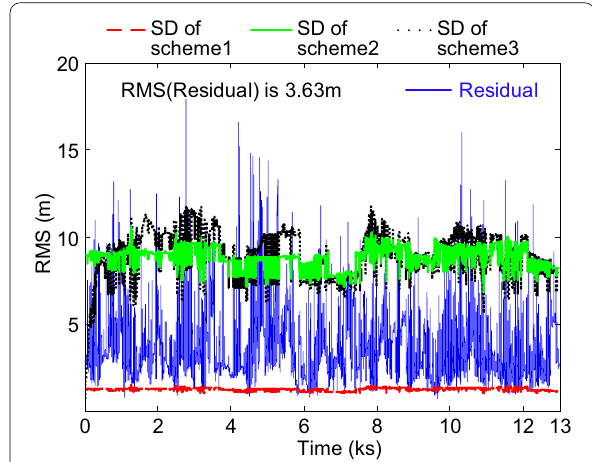
Fig. 12 RMS of pseudorange measurement residuals and standard deviation estimates